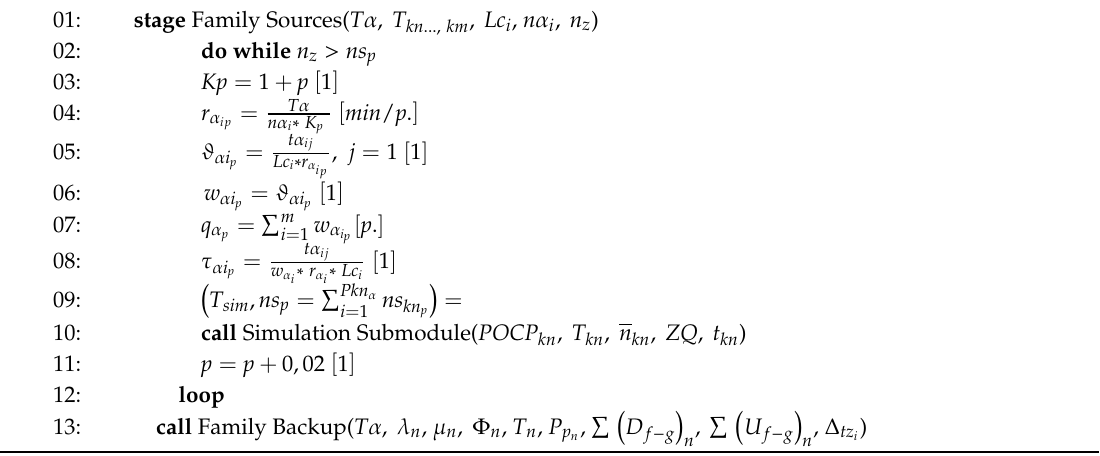
Algorithm 5 Creating the Product Family and the Resource Availability—Part